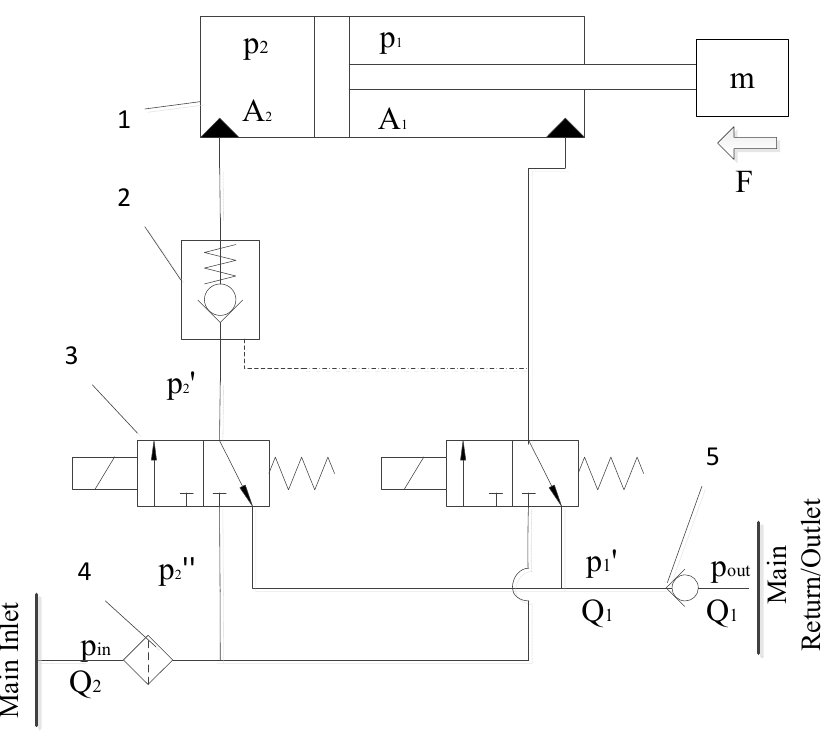
Figure 5. Working principle of a hydraulic cylinder system. 1. Hydraulic cylinder; 2. Liquid control check valve; 3. Directional valve; 4. Filter; 5. Return circuit breaker.